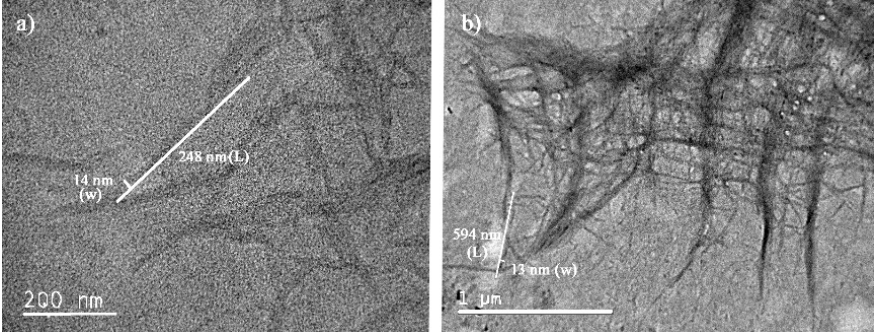
Figure 5. TEM observation of P-CNCs prepared with different sulfuric acid concentrations: ( a ) 63%; ( b ) 46%.